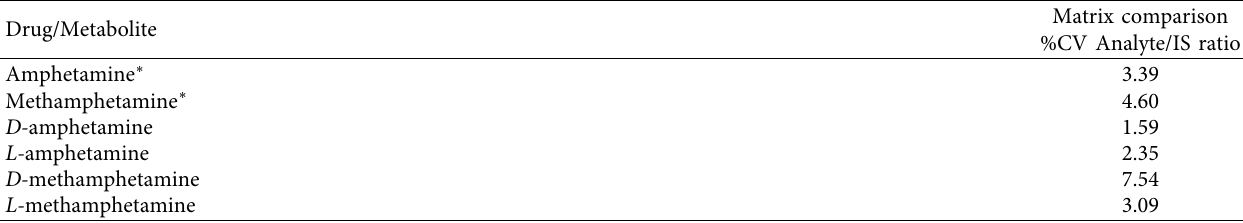
Table 9: Matrix efects 10 diferent lots of oral fuid were fortifed with QC material to a concentration of 7.5ng/mL and the %CV determined of the analyte/IS area ratio.